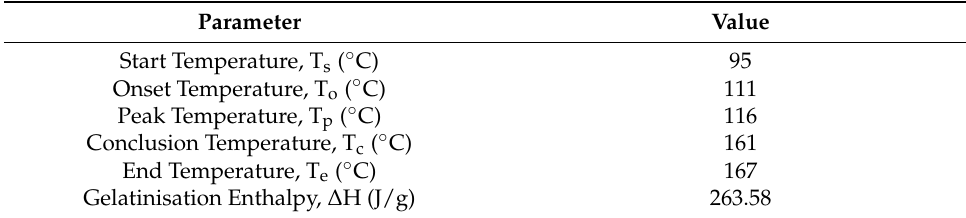
Table 1. Thermal properties of pineapple plant